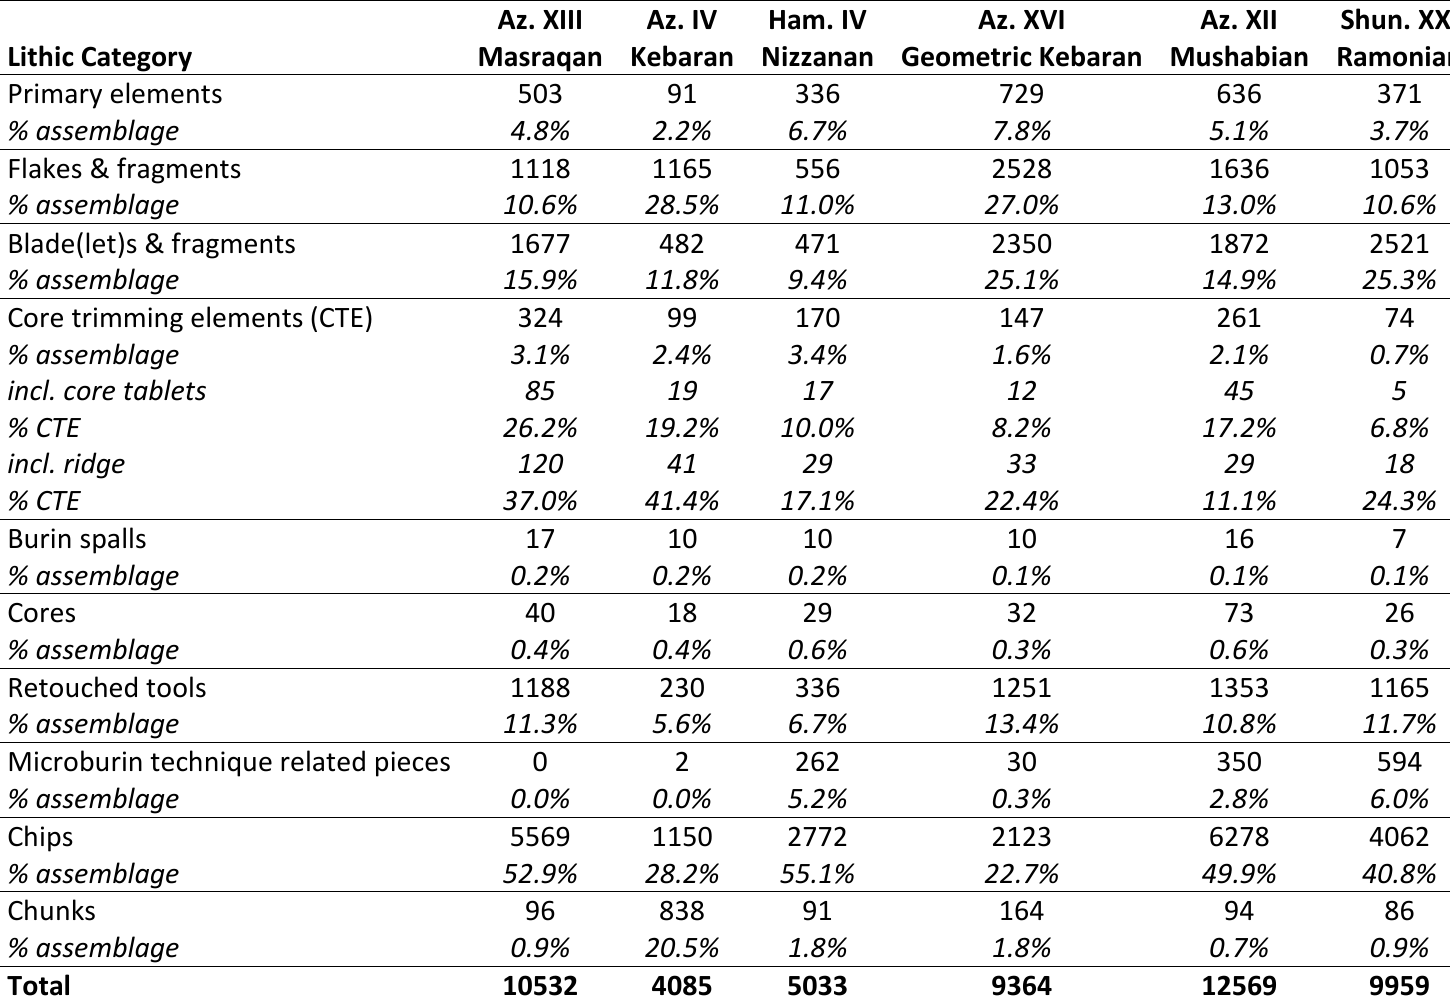
Table 2. Raw counts by class of the studied lithic assemblages (data from Goring-Morris 1987; Goring-Morris et al. 1998; Marder 2002). Abbreviations: Az. = Azariq, Ham. = Hamifgash, Shun. =